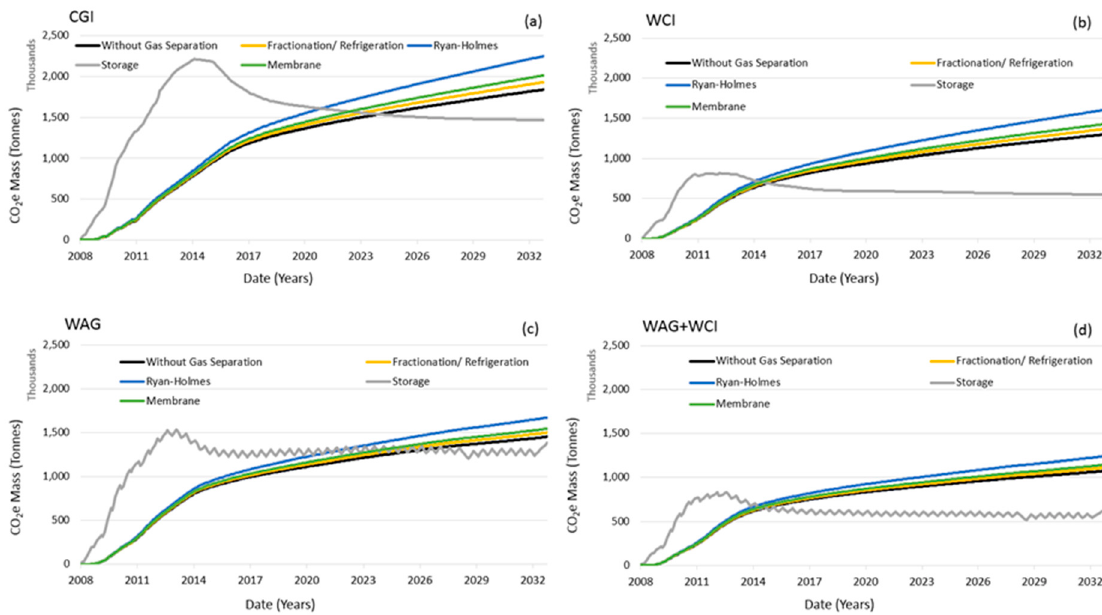
Figure 6. CO 2 storage mass (gray curves) versus CO 2 e emissions (colored curves) of the gate-to-grave CCUS system for: ( a ) continuous gas injection, ( b ) water curtain injection, ( c ) water-alternating-gas, and ( d ) the hybrid scenario.